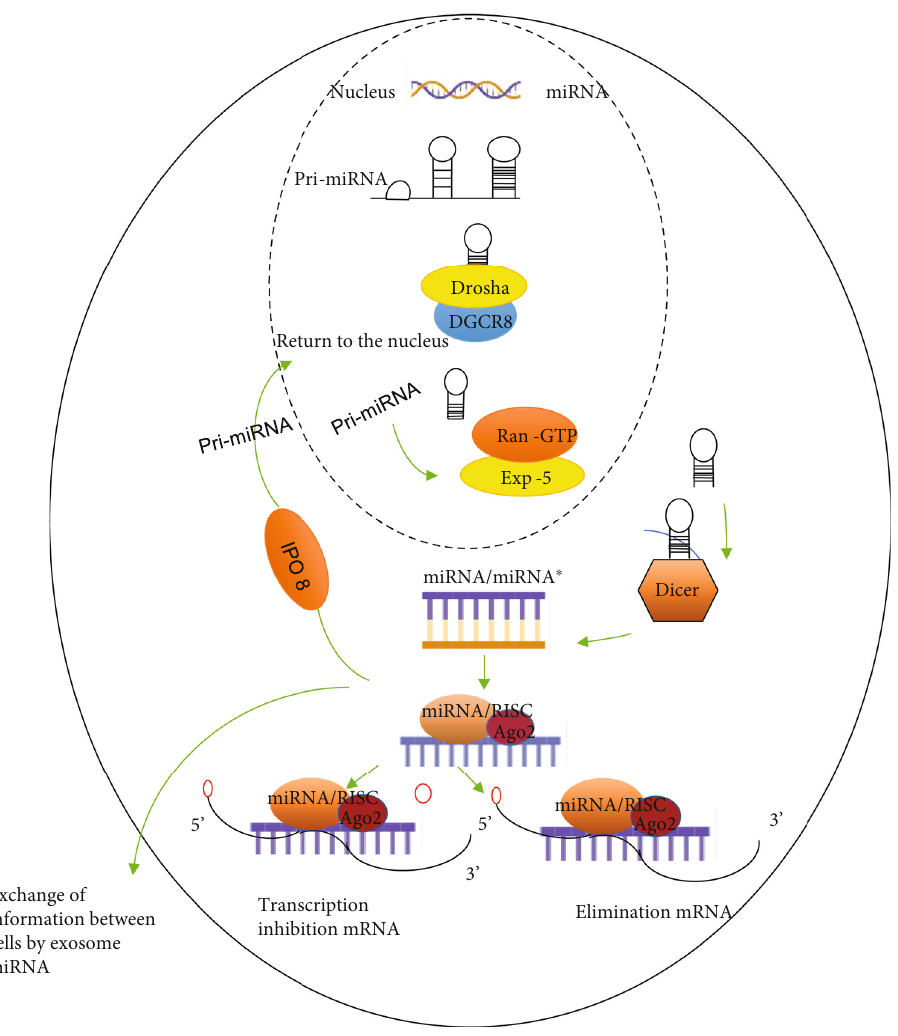
Figure 1: miRNA biosynthesis processing.